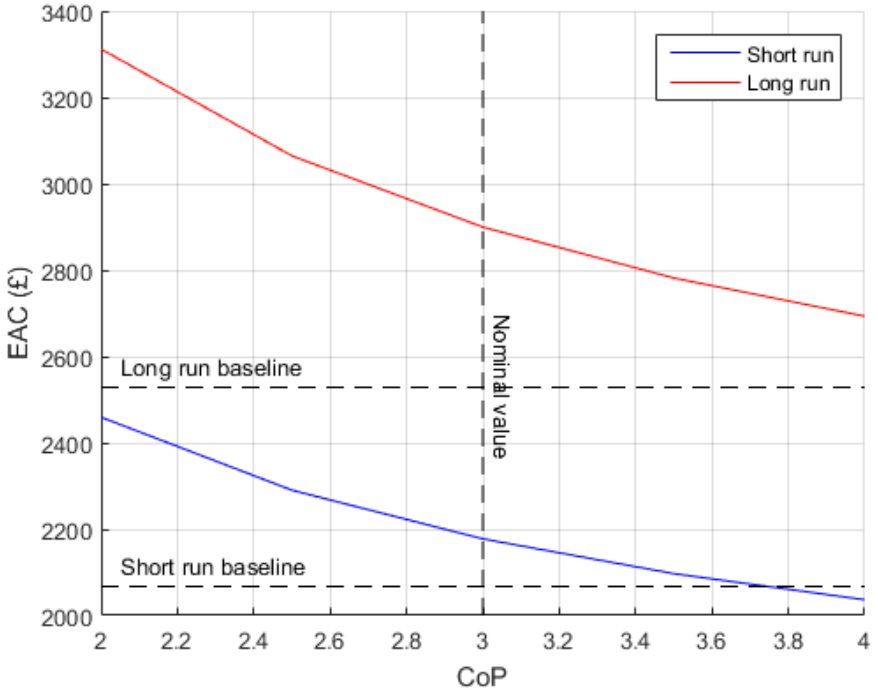
Figure 13. Influence of heat pump design on economic performance.